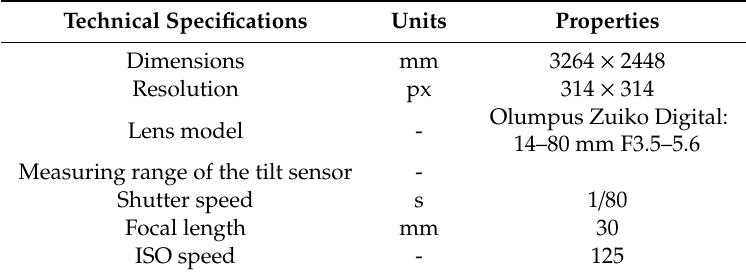
Table 2. Technical specifications of the OLIMPUS E-500 DSLR digital camera and the taken photographs.